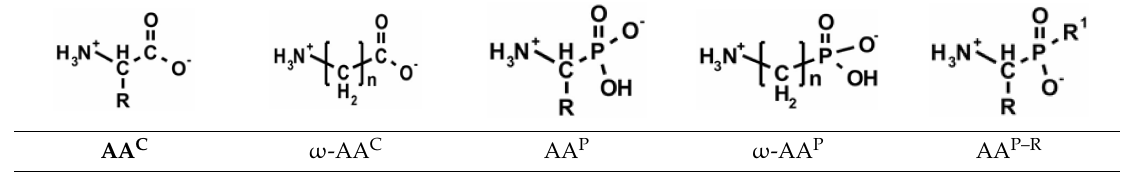
Table 1. Structures of aminophosphonic acids (AA P )—phosphonic analogs of amino acids (AA C )